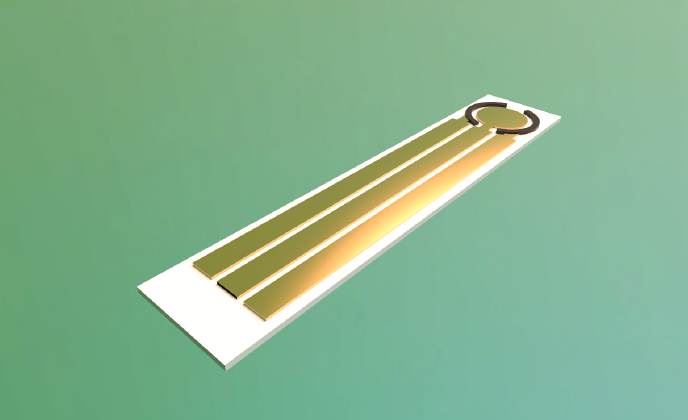
Figure 5. Rendered 3D model of the fabricated MIP sensor.